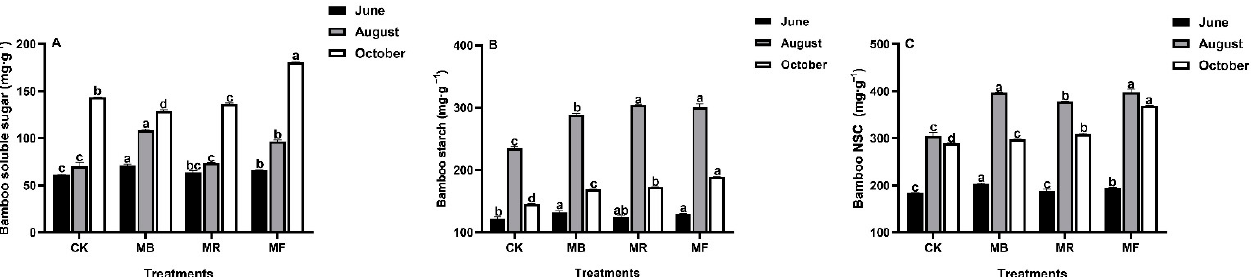
Figure 4. The effect of mulch treatments on carbohydrate contents in bamboo shoots, where MB: bamboo leaves mulch, MR: rice husks mulch, MF: organic fertilizers mulch, and CK: control. ( A ) Bamboo soluble sugar; ( B ) Bamboo starch; ( C ). Bamboo NSC. Various letters on each bar show significant differences ( P < 0.05) with vertical bars as standard errors ( n = 4).